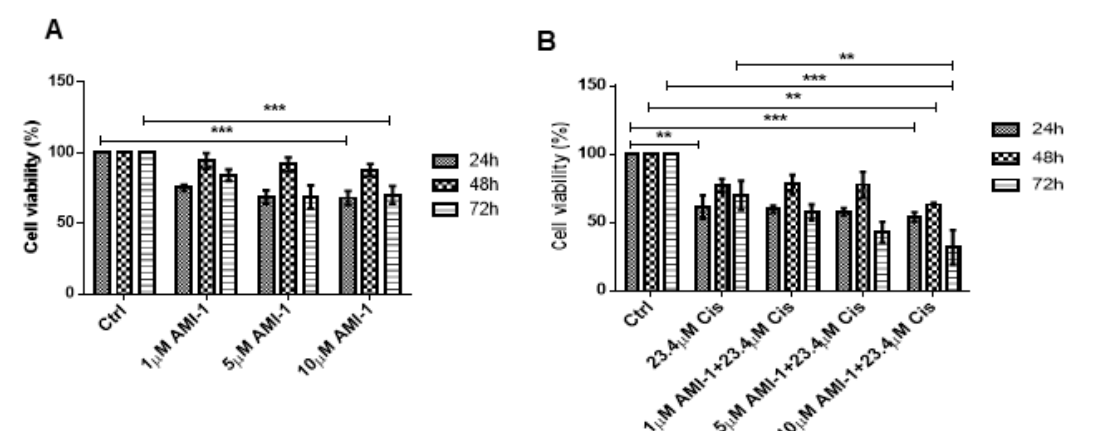
Figure 2. AMI-1 alone and in combination with cisplatin reduces the viability of A549 cells. The cellular viability of A549 cells upon treatment with AMI-1.; cisplatin or both was measured using MTT colorimetric assay. ( A ) A549 cells were exposed to several AMI-1 concentrations (1, 5, and 10 µ M) and viability was analyzed at 24, 48 and 72 h. AMI-1 inhibited cellular viability at concentrations of 10 µ M when treated for 48 h. ( B ) Cells were treated with cisplatin alone and in combination with 1, 5 and 10 µ M AMI-1., and viability was assessed at 24, 48 and 72 h. 10 µ M AMI-1 in combination with IC 50 of cisplatin (23.4 µ M) significantly inhibited cell survival at 72 h. Data are normalized to untreated control (Ctrl) and is representative of two independent experiments. * represents a statistically significant change in viability between the indicated treatment groups at given time points. ** p < 0.01.; *** p < 0.001.